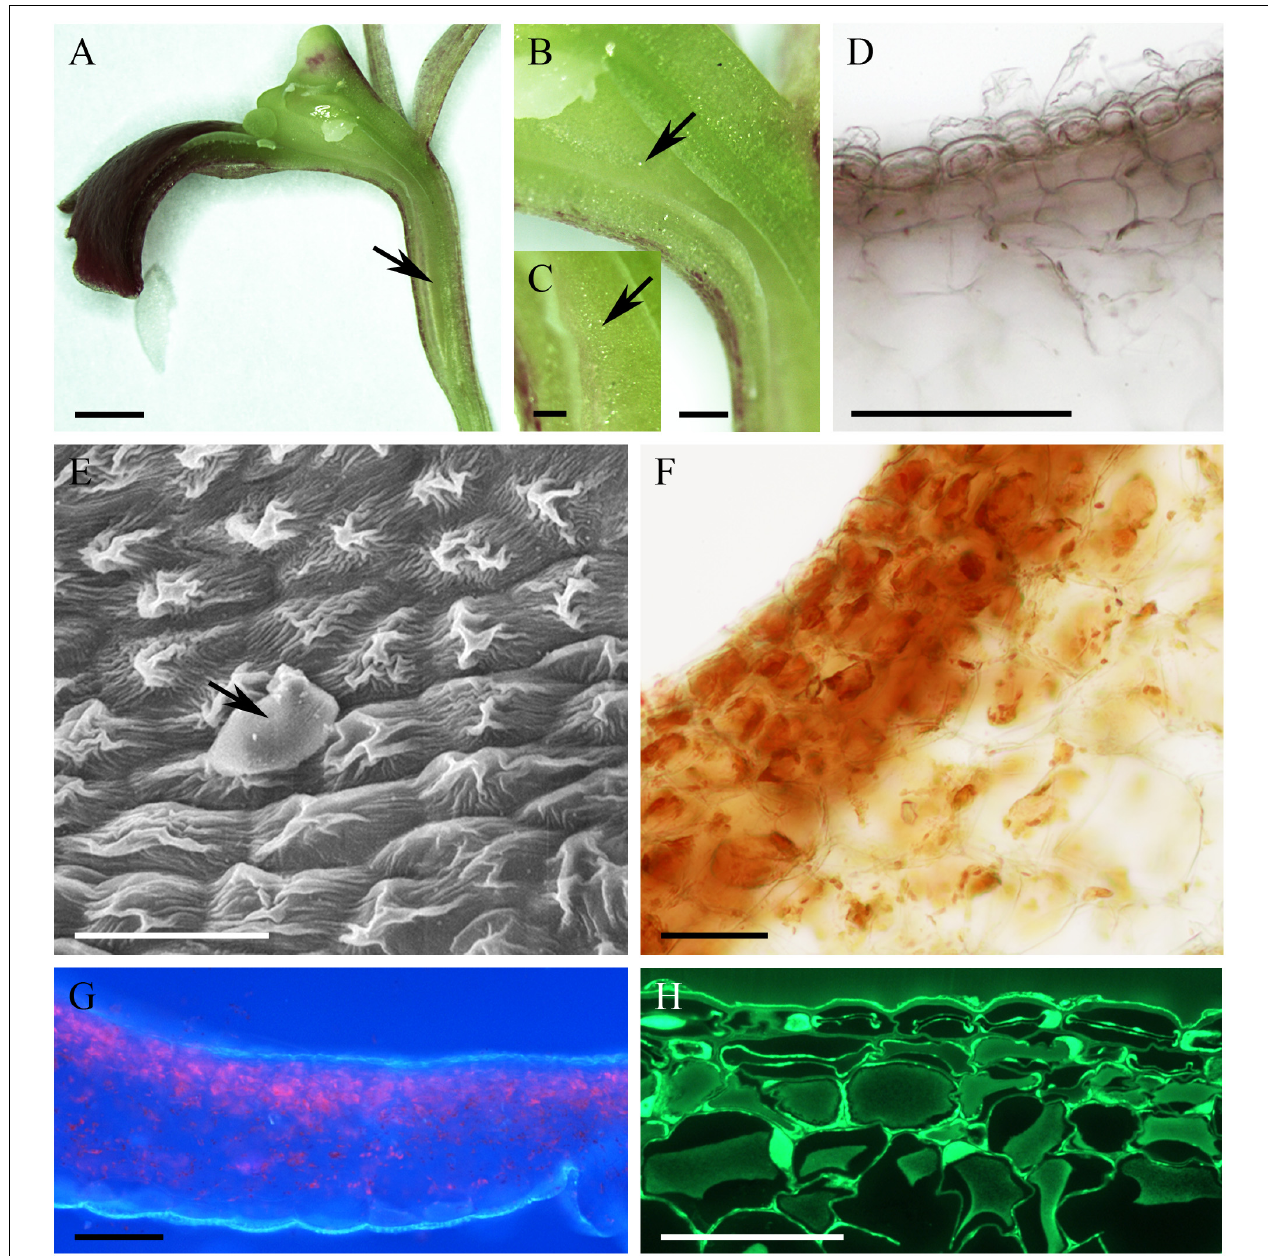
FIGURE 3 | Epidendrum porpax . (A) Longitudinal section of flower. Cuniculus indicated by arrow. (B,C) Details of cuniculus with small droplets of nectar (arrows). (D) Epidermal cells with surface secretion and subepidermal parenchyma (unstained, hand-cut section,). (E) Surface of epidermis with nectar residue (arrow). (F) Section stained with IKI; note starchless plastids. (G) Longitudinal section of cuniculus, the lumen visible at its top. Autofluorescence of chlorophyll located in subepidermal and ground parenchyma on exposure to UV. (H) Thin cuticle of epidermal cells with secretory residues. Beneath the epidermis occur large, thin walled parenchyma cells (auramine O). Scale bars: A = 2 mm; B = 500 µ m; C = 200 µ m; D,G = 100 µ m; E,F,H = 50 µ